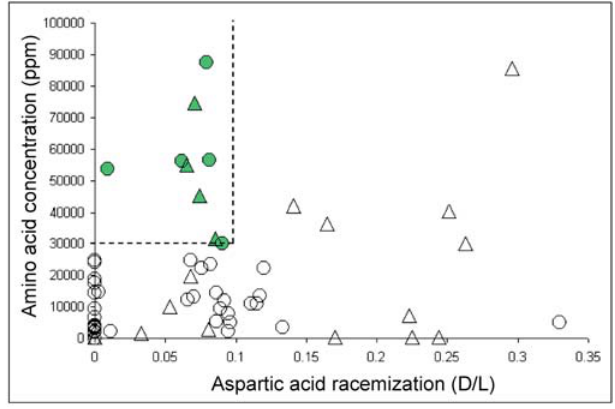
Figure 1. Amino Acid Analyses of 64 Hominid Remains For each bone, the extent of aspartic acid racemization (D/L) and the amino acid concentration (ppm) is given. The dash lines delimit the area of amino acid preservation compatible with DNA retrieval. Circles and triangles represent early modern humans and Nean- dertals, respectively. The samples from which DNA extractions were performed are green (see also Table S1). DOI: 10.1371/journal.pbio.0020057.g001